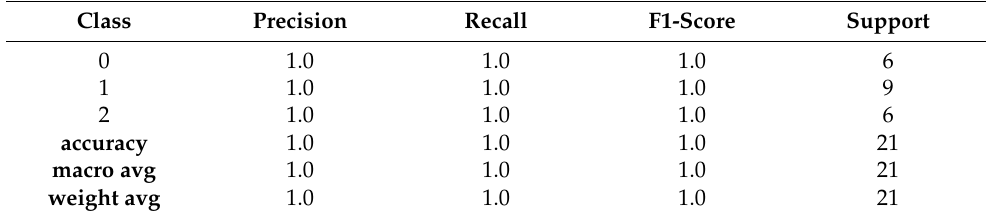
Table 3. Ensemble model metrics for sorting salmon